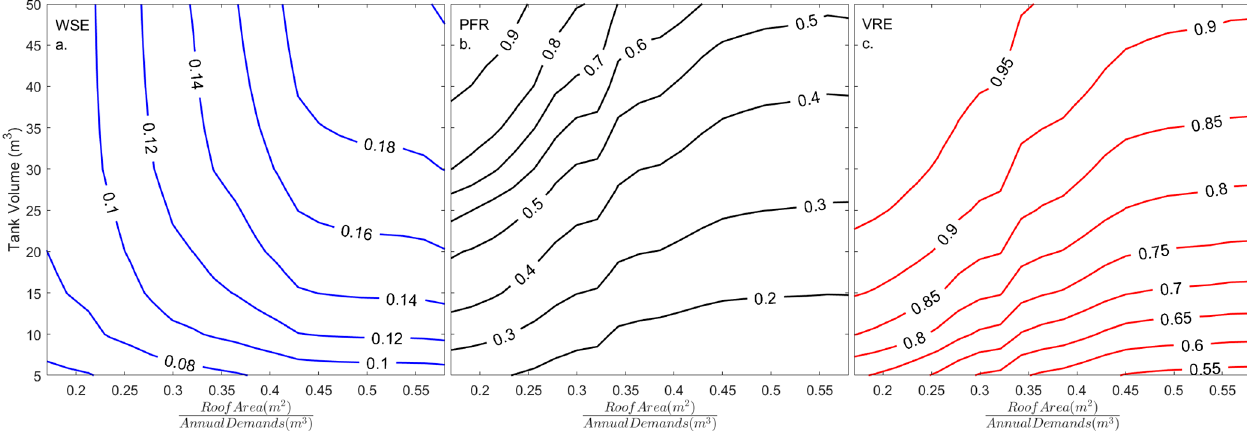
Figure 5. WSE PFR and VRE as a function of normalized roof area (roof area divided by annual demands), and rainwater tank volume. Contours represent constant WSE ( a ), PFR ( b ) and VRE ( c ) values.